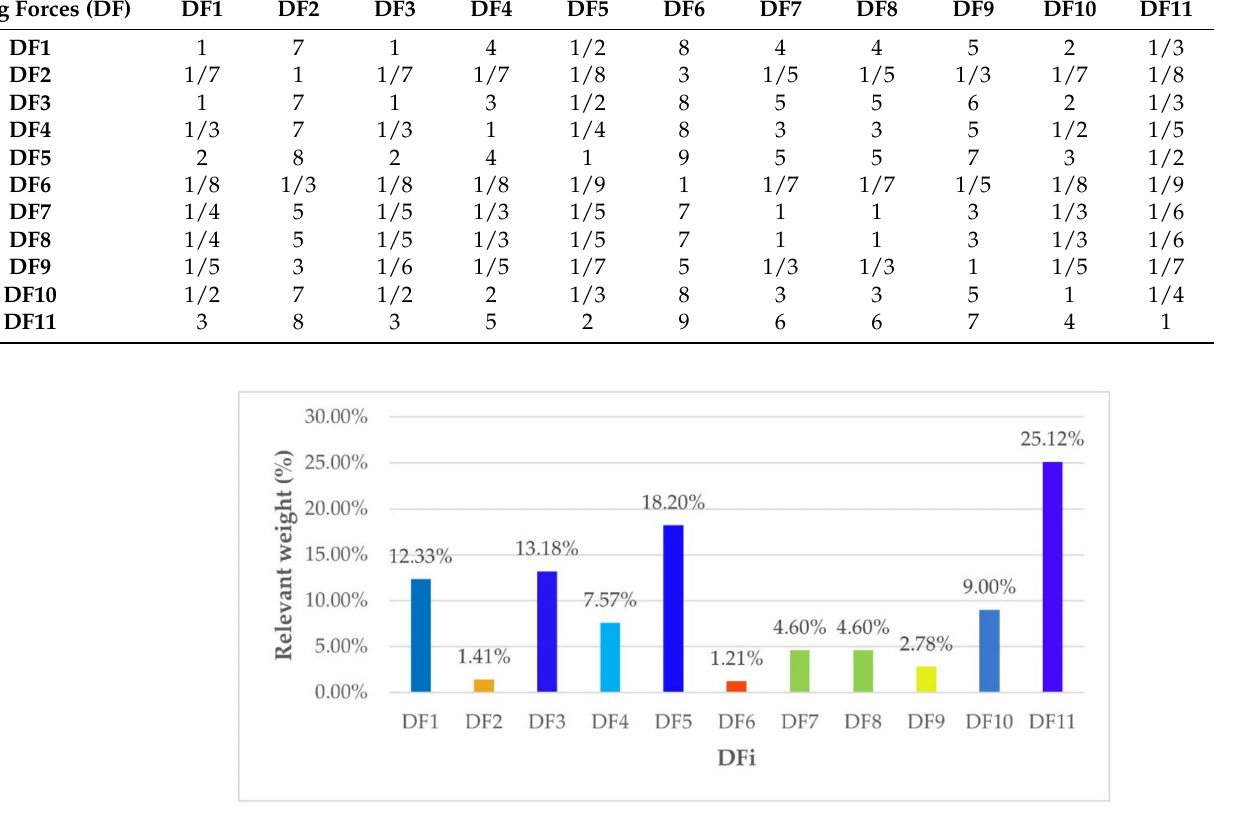
Figure 5. Relevant weights of Driving Forces DF1–DF11 with respect to the